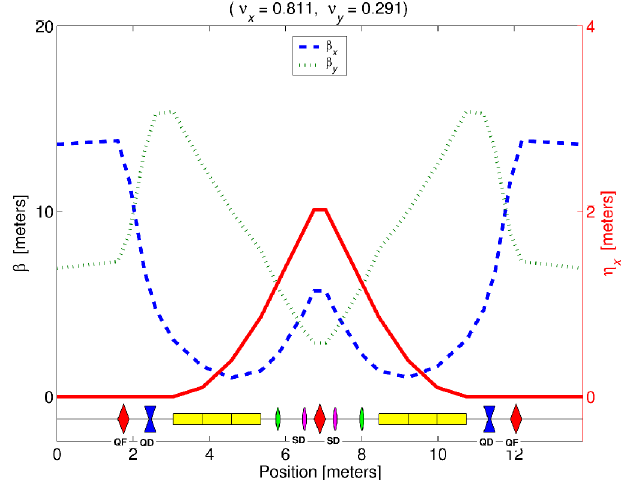
FIG. 11. (Color) Lattice of one of 4 CAMD sectors and asso- ciated lattice functions in a nominal operational mode starting from the center of one straight section and going to the center of the following straight